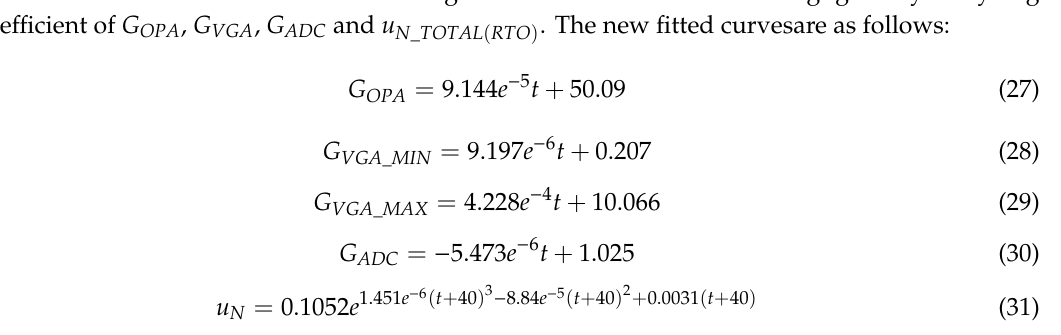
Figure 9. The layout of heater and sensor of temperature control for QD. The target temperature is set to 30 °C. A temperature tolerance N Figure 10. The process of temperature control for QD.